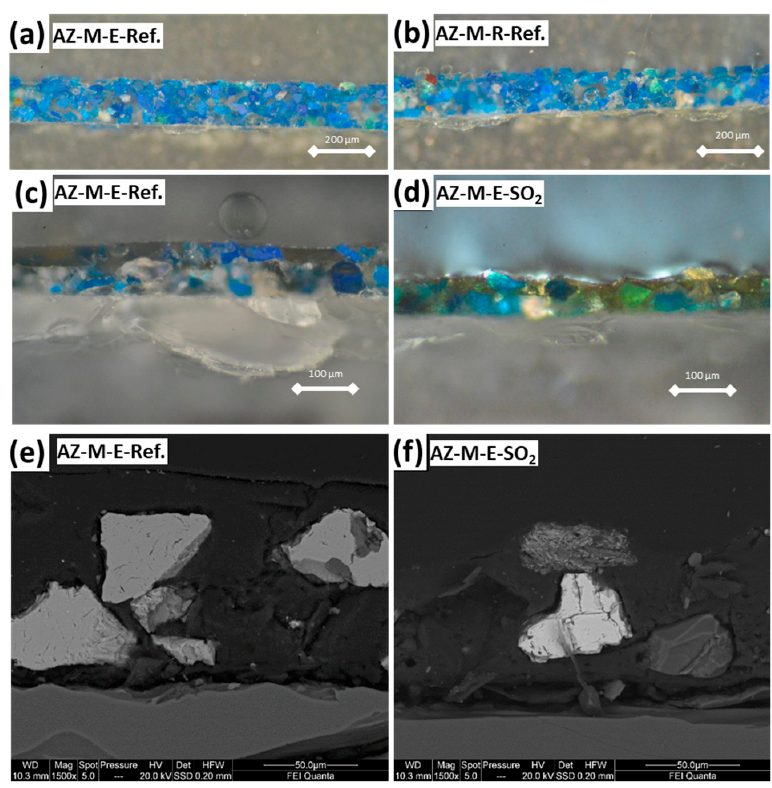
Figure 8. Micrographs taken with PLM (plane polarized light) from cross sections of reference azurite- based paints made with egg yolk ( a ) and with rabbit glue ( b ); reference ( c ) and SO 2 aged ( d ) AZ-M paints made with egg yolk (E). ( e ) and ( f ) are SEM micrographs of ( c ) and ( d ). Reference (Ref): fresh paints; Aged SO 2 paint: SO 2 . See Table 1 for the labeling of paint mock-ups.